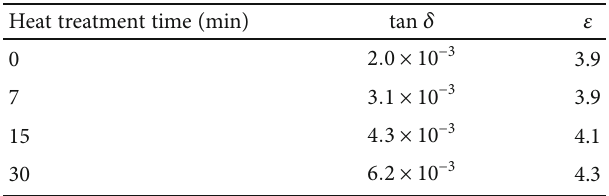
Figure 5: FT-IR spectrum of cured MDPES-2 before and after thermal treatment at 500 ° C. Table 6: E ff ect of thermal treatment at 500 ° C on dielectric property of MDPES-2